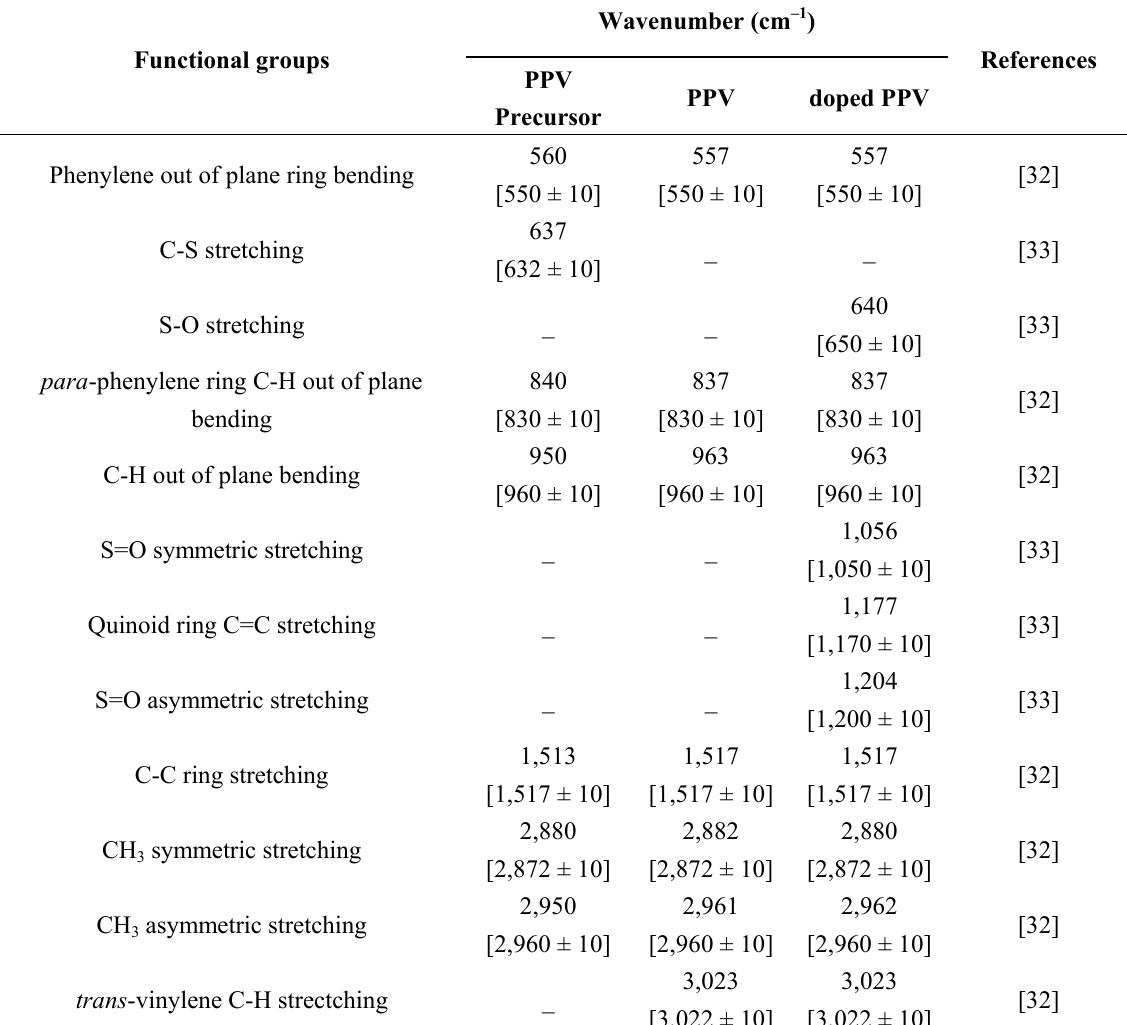
Table 1. Peak positions from FT-IR spectra of PPV precursor, PPV, and doped PPV with a mole ratio of sulfuric acid to monomer unit equal to